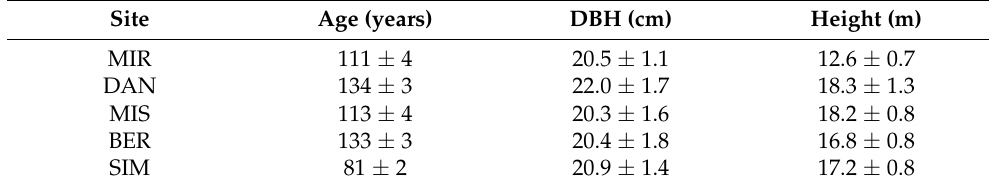
Table 1. Information on sampled trees at the five permanent sites in the boreal forest of Quebec, Canada.